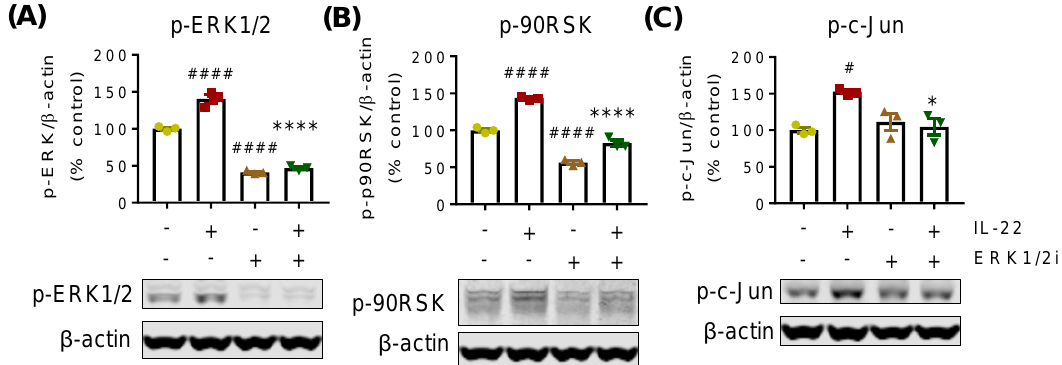
Figure 4. Activation of p90RSK and c-Jun by ERK1 / 2. LS174T cells were treated with 50 ng / mL of IL-22 for 30 min following 1 h pre-treatment with ERK1 / 2 inhibitor (10 µ M). Cells were lysed and Western blotting was performed to detect phosphorylated ( A ) ERK1 / 2, ( B ) p90RSK, and ( C ) c-Jun. Data are presented as mean ± SEM with individual cultures ( n = 3). # p < 0.05; #### p < 0.0001 compared with control and * p < 0.05; **** p < 0.0001 compared with IL-22 (one-way ANOVA followed by Dunnett’s post-hoc test).